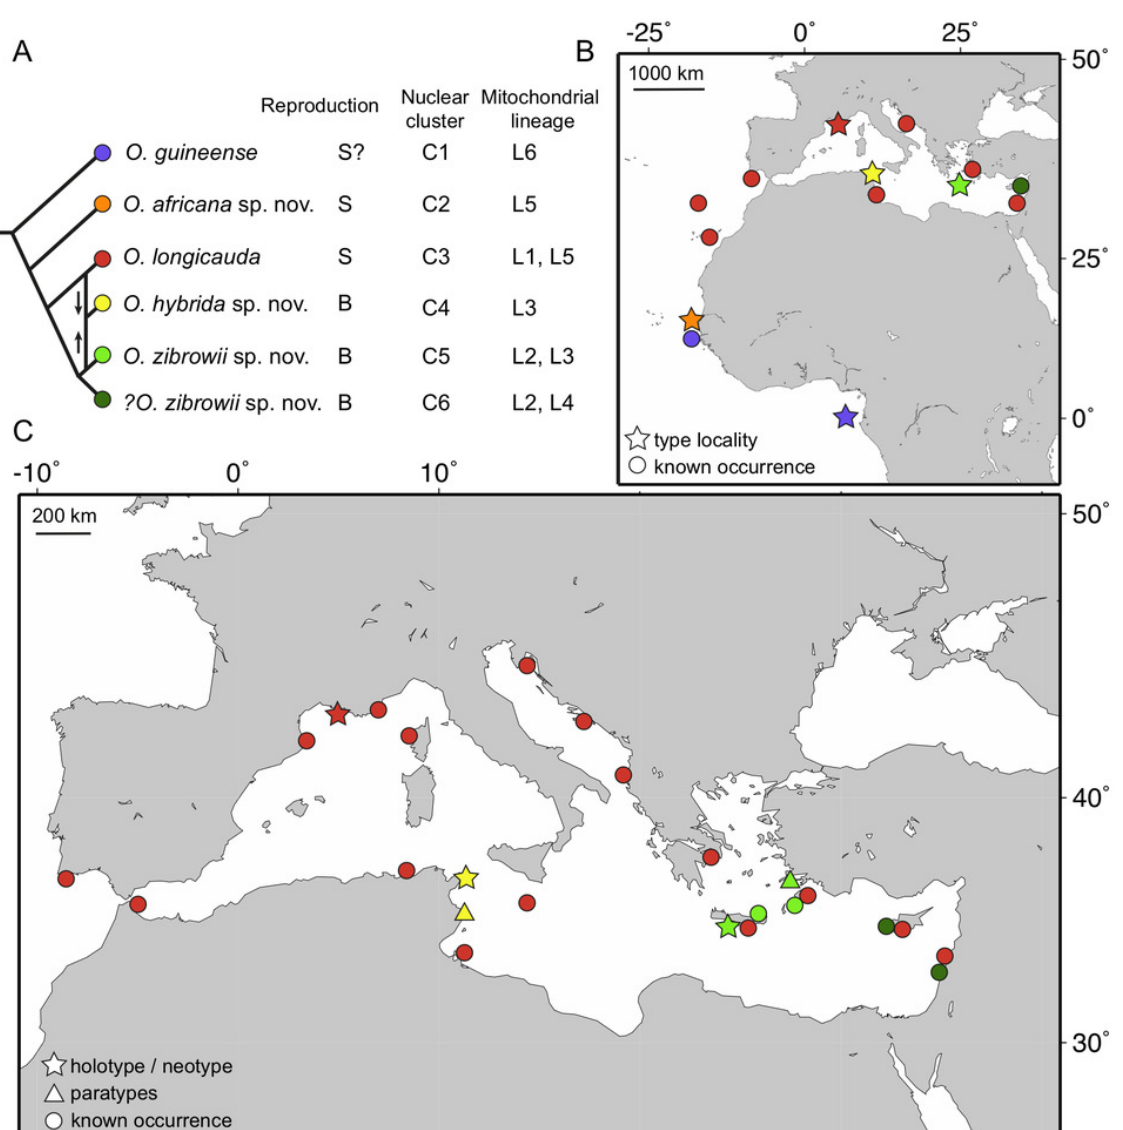
Fig. 1. Phylogenetic relationships and distribution of species of Ophioderma Müller & Troschel, 1840 in the Northeast and Tropical Atlantic Ocean and the Mediterranean Sea. A . Simplified phylogenetic relationships among species of Ophioderma described in this study, modified from Weber et al. (2019). Summary of reproductive strategy: S = broadcast spawner; B = brooder. Correspondence between species names, nuclear genetic clusters and COI mitochondrial lineages is summarized from Boissin et al. (2011) and Weber et al. (2019). C6 is tentatively assigned to O . zibrowii sp. nov. because it occurs far from the type locality and brooding species are expected to have low dispersal rates, leading to low gene flow between populations. B . Distribution of species of Ophioderma in the Northeast and Tropical Atlantic Ocean. C . Distribution of species of Ophioderma in the Mediterranean